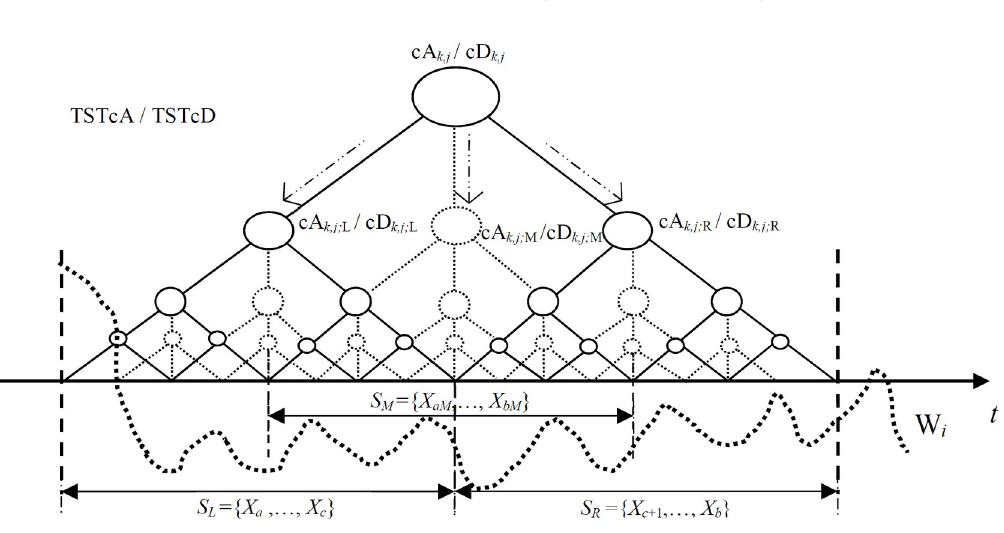
Fig 2. The scheme of TSTcA/TSTcD construction by adding the virtual middle branches cA k,j:M /cD k,j:M into the existing binary trees in each of non-leaf levels.